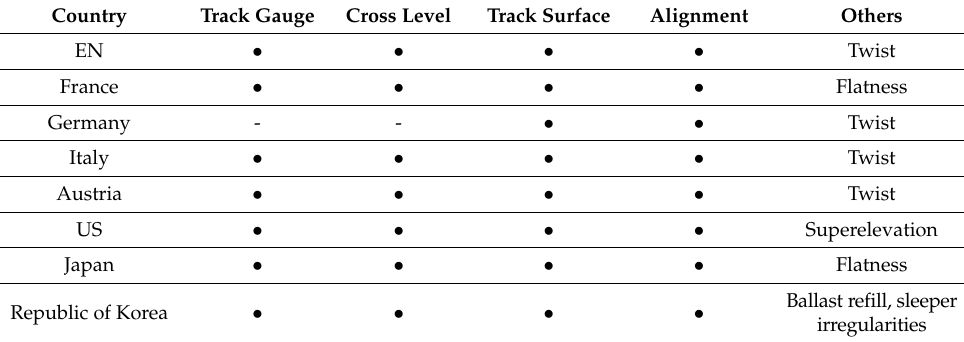
Table 1. Track irregularity management criteria by country.